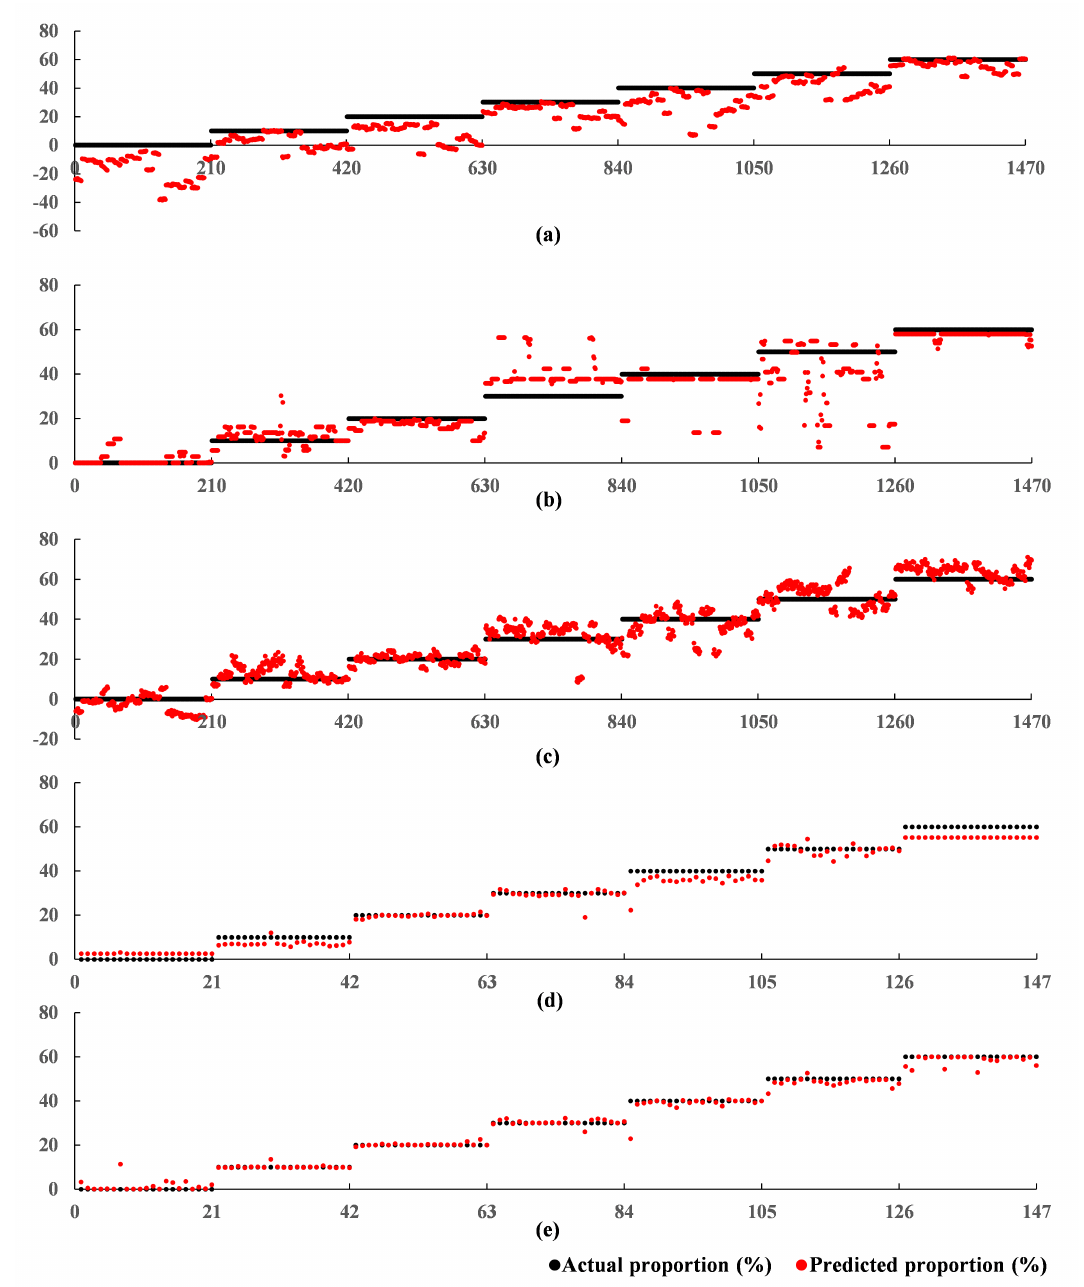
Figure 9. Relationships between the predicted adulterated proportions of the five models and the actual adulterated proportions in Experiment B. ( a ) SVR; ( b ) RFR; ( c ) BPNN; ( d ) 1DCNN; ( e )